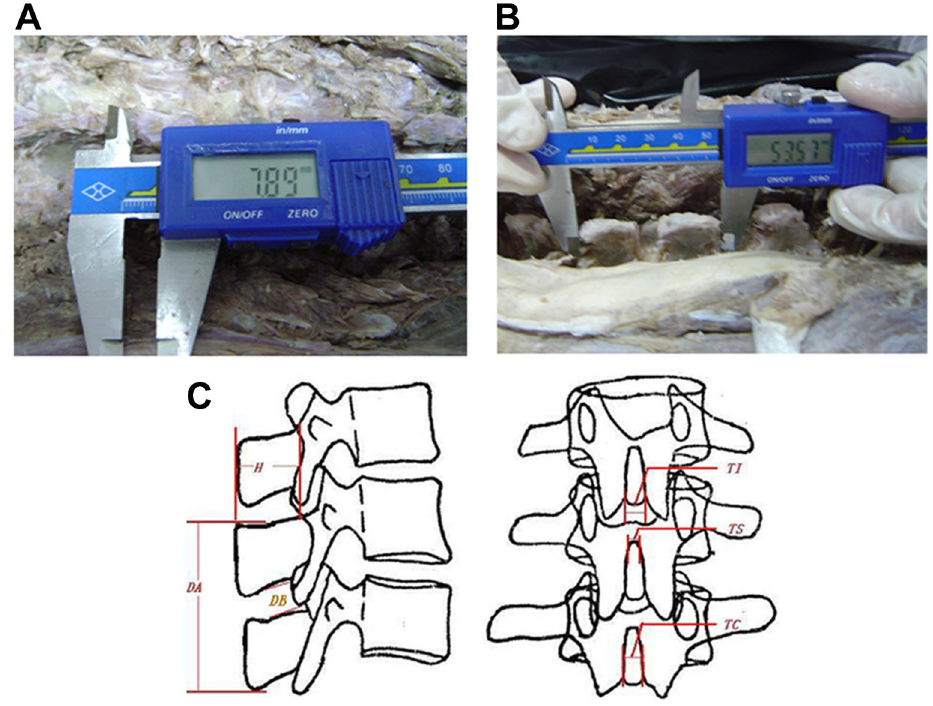
Figure 1. Illustration of measuring method for each parameter. A , Measurement of DB; B , measurement of DA; C , schematic diagram of H, DA, DB, TI, TS, and TC. H: height of the spinous processes; DA: distance across two adjacent spinous processes; DB: distance between two adjacent spinous processes; TI: thickness of the inferior margin of the spinous processes; TS: thickness of the superior margin of the spinous processes; TC: thickness of the central spinous